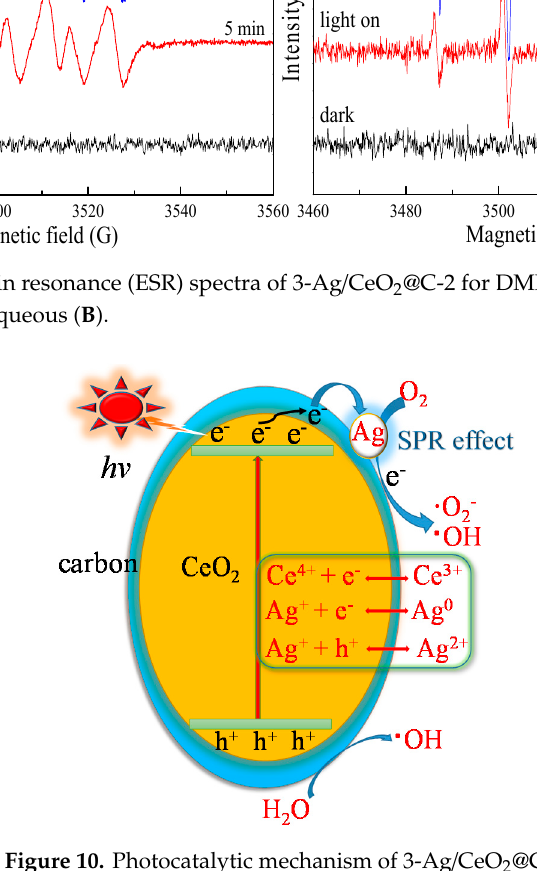
Figure 10. Photocatalytic mechanism of 3-Ag/CeO 2 @C-2.